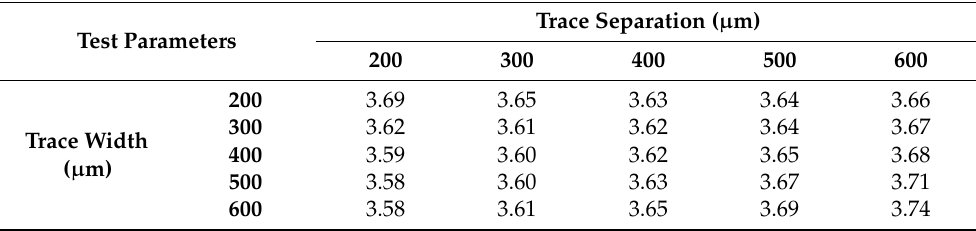
fabricated elliptical inductors with a trace width of 600 μ m and trace separation varying from 200 μ m to 600 μ m, while the major-to-minor ratio ( R ) and N are kept constant at 3 and 10, respectively. Table 2. Inductance of elliptical inductors calculated from the proposed model for different combina- tions of trace separation ( S ) and trace width ( W ) while major-to-minor ratio ( R ) = 3 and number of turns ( N ) = 10.